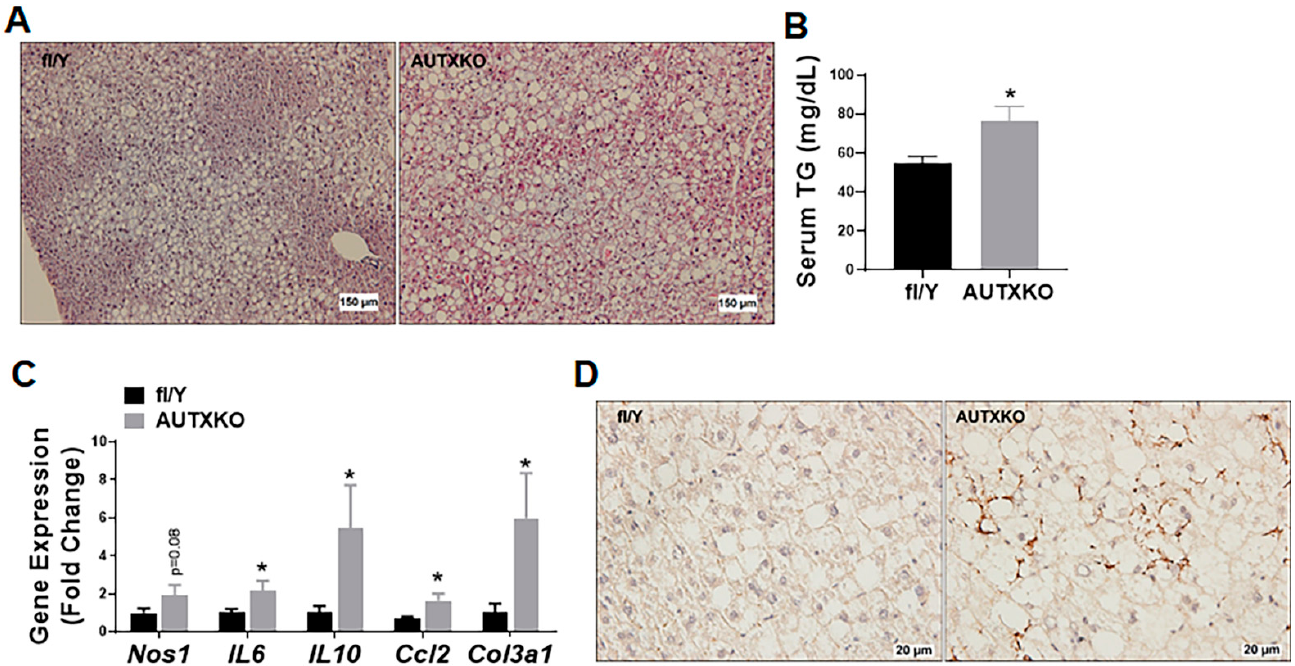
Figure 8. Utx deficiency in adipocytes causes hepatic steatosis in AUTXKO mice. Five-week-old male AUTXKO and fl/Y animals were challenged with an HFD. ( A ) H&E staining of the liver. ( B ) Triglyceride levels in circulation. ( C ) RT-PCR measurements of genes encoding inflammatory and fibrogenic pathways in the liver of AUTXKO and the control mice. ( D ) Immunohistochemical analysis of macrophages stained with an anti-CD68 antibody in the liver. All data are presented as mean ± S.E.M.; n = 7–11/group; * p < 0.05 vs. fl/Y .